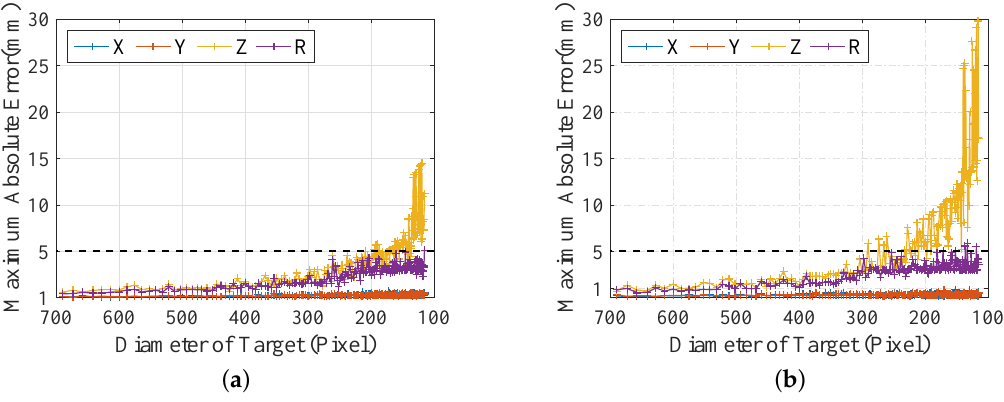
Figure 7. Simulation of the pose errors with different pixels of the diameter: ( a ) result with 0.5 pixels of noise; ( b ) result with one pixel of